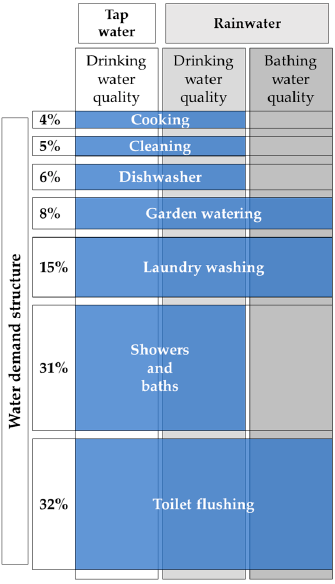
Figure 1. Matrix of water usage and allowed water quality in household needs [13,14,17,18,28–30].